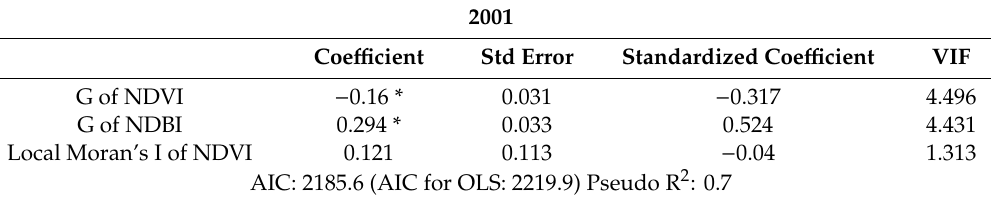
Table 2. Parameter estimation and diagnostics for the spatial error model for 2001, 2008, and 2013. 2001 Coe ffi cient Std Error Standardized Coe ffi